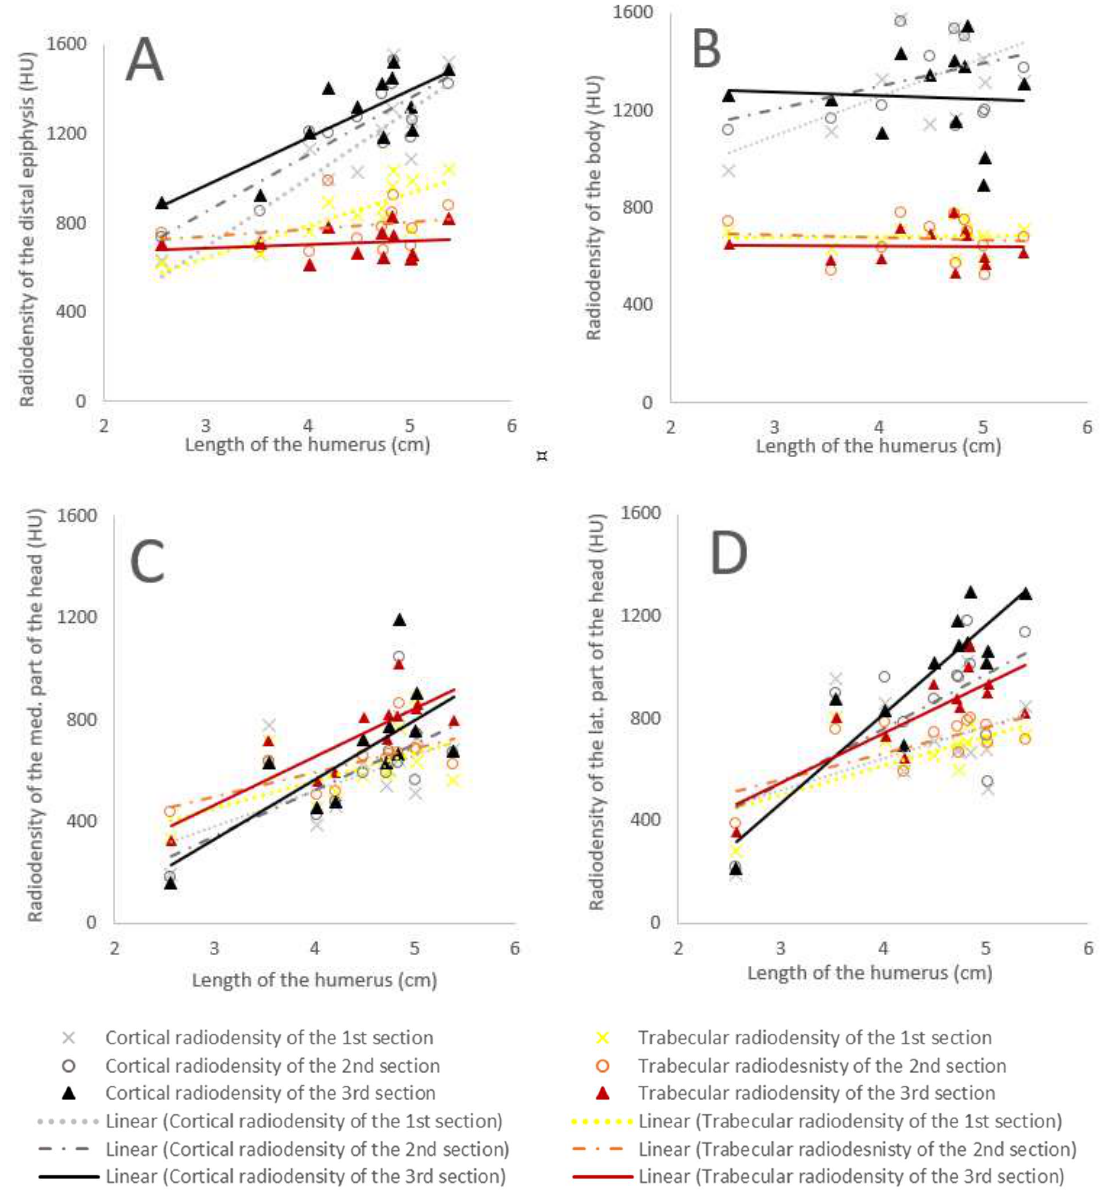
Figure 2. The graphs show how the different humeral portion radiodensities changed in relationship with the humeral length in the Atlantic spotted dolphins: ( A ) the humeral distal epiphysis, ( B ) the humeral body, ( C ) the medial aspect of the humeral head, and ( D ) the lateral aspect of the humeral head. Black and grey lines represent cortical bone density values (CD), while the red, orange, and yellow lines represent trabecular bone density values (TD). Dotted lines represent the regression lines for the first section, dashed lines are for the second section, and the continuous line depicts the third section.